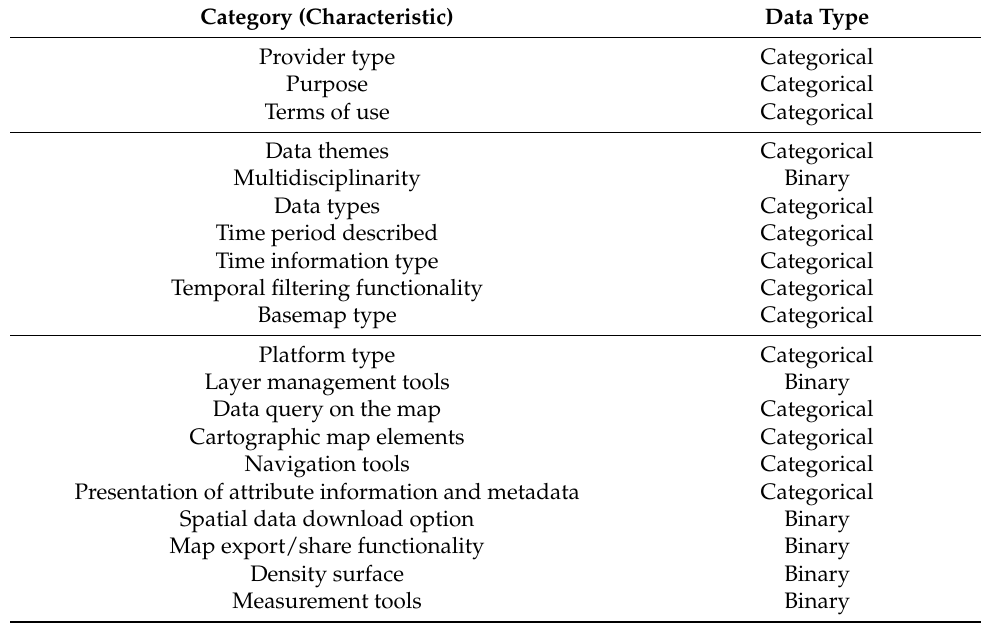
Table 1. Main categories considered for the reviewed spatial data